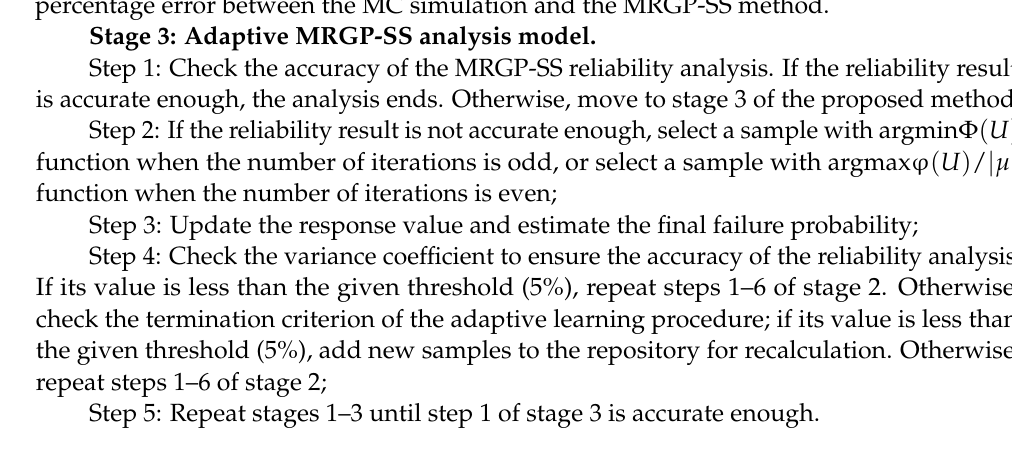
Figure 2. Flowchart of the proposed method.